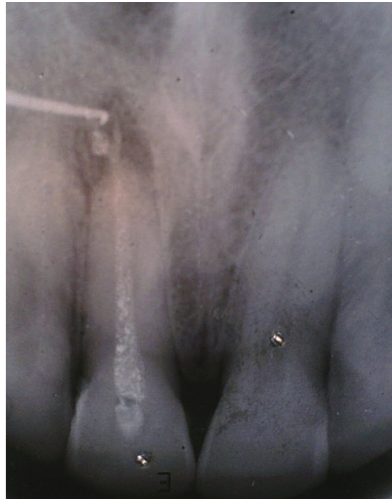
Figure 4: Radiograph showing gutta percha tracing of the sinus tract.